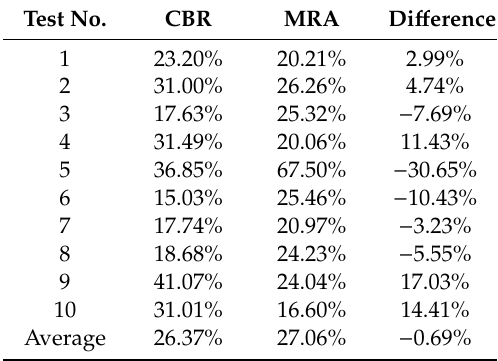
Table 4. Average error rate of each test. MRA: multiple regression